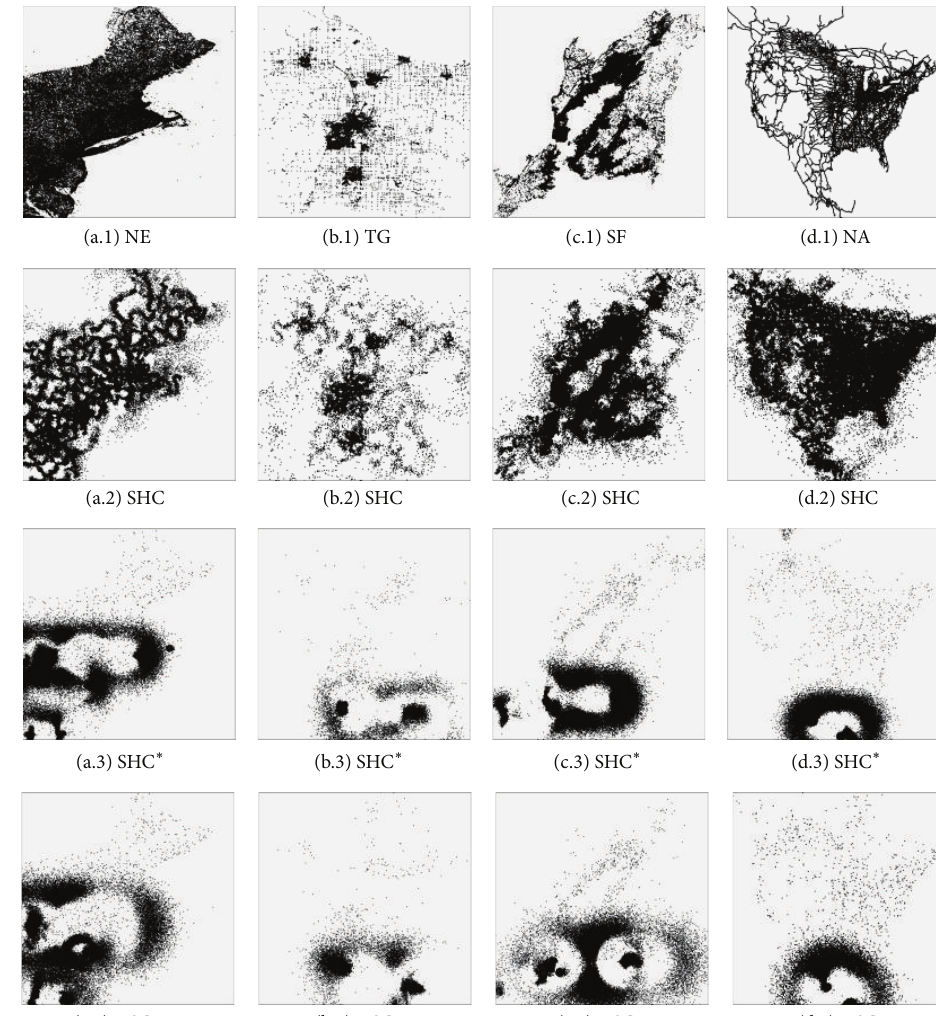
Figure 8: Visualization of